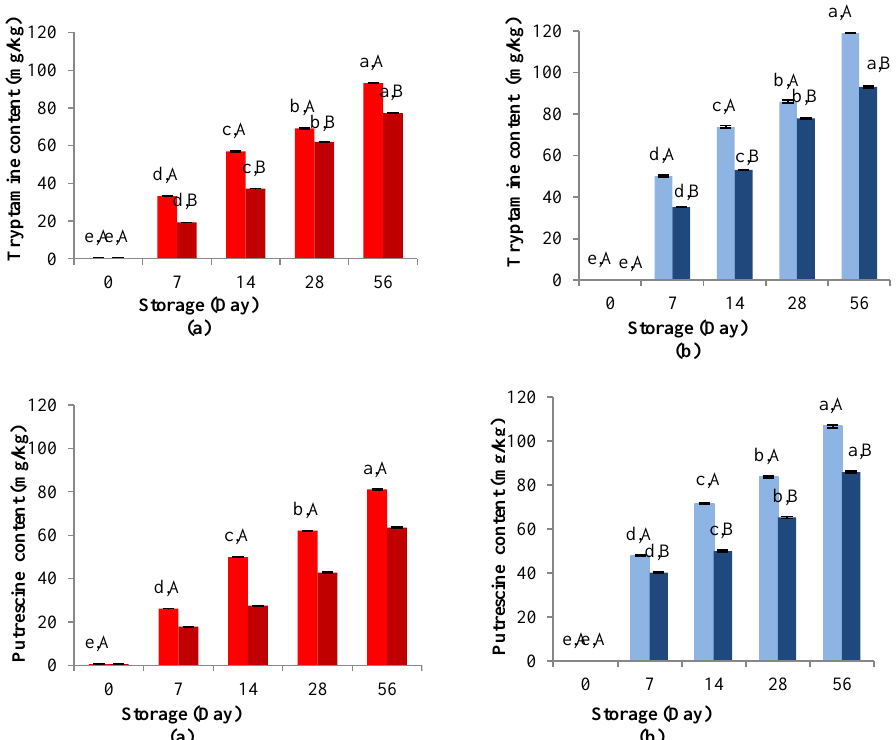
Figure 1. Biogenic amine content (mg/kg) in red beet ( Beta vulgaris ) ( a ) and brines ( b ).